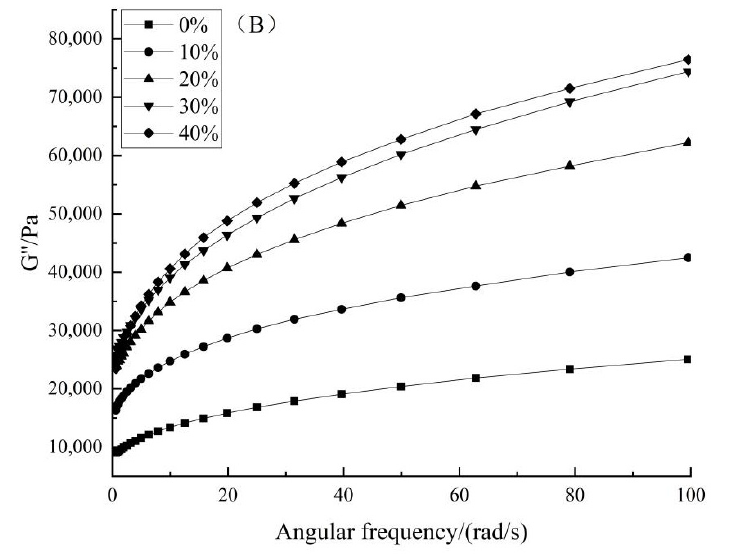
Figure 1. Effects of wheat flour supplemented with different contents of GBP on dynamic rheological properties of dough. Storage moduli (G ′ ) ( A ) and loss moduli (G ″ ) ( B ). Power-law equations were employed for fitting the G (cid:48) and G” values. As shown in Table 5, the dependence of the dynamic moduli of G (cid:48) and G” on the angular frequency can be well-fitted by Equations (1) and (2) for an angular frequency range from 1 to 100 rad/s. The values of the coefficients of determination (R 2 ) for G (cid:48) and G” are greater than 0.996 and 0.977, respectively. It indicates that the power-law model can well describe the viscoelastic properties of GBP dough samples. The values of K (cid:48) are higher than the values of K”, and the values of n’ are lower than those of n”. The K (cid:48) values increased with the increase of GBP contents. When the content of GBP increased from 0% to 30%, the K” values increased with the increase of the GBP contents. When the content of GBP reached to 40%, the K” value was lower than that of 30% GBP content dough. Meanwhile, GBP contents have a slight effect on the n (cid:48) and n” values. These results indicate the GBP could enhance the